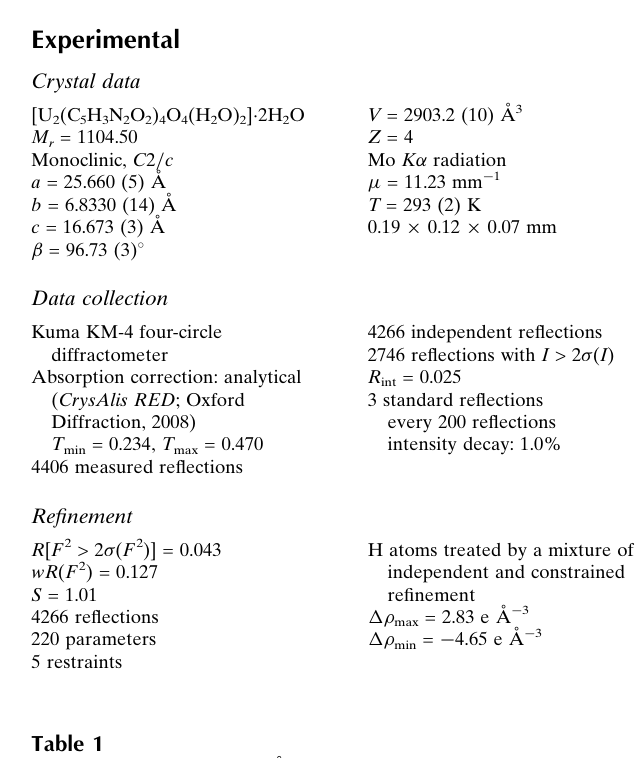
Hydrogen-bond geometry (A˚ , (cid:2)